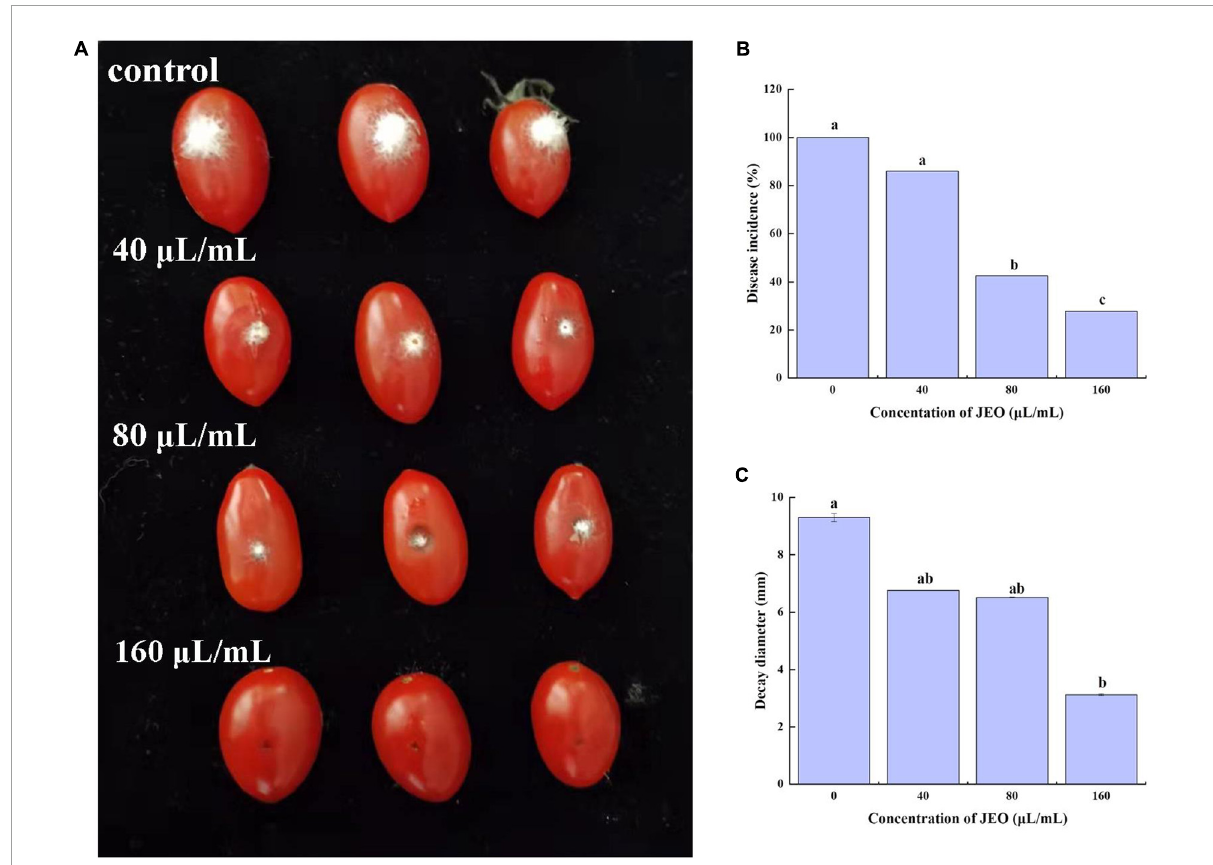
FIGURE3 Effect of JEO on infection with B. cinerea in cherry tomato fruits after harvest. Each cherry tomato was inoculated with a 10 µ L spore suspension of B. cinerea at 1 × 10 6 spores/mL and then treated with JEO at different concentrations (0 as control, 40, 80, and 160 µ L/mL) for 4 d at 25 ◦ C. The representative photographs (A) , disease incidence (B) and decay diameter (C) of the cherry tomatoes were recorded on day 4 after inoculation. The bars represent the standard error of the mean ( n = 3). Letters (a, b, c, d) represent statistically significant differences between different concentrations according to Duncan’s multiple range test ( P < 0.05). JEO, juniper essential oil.